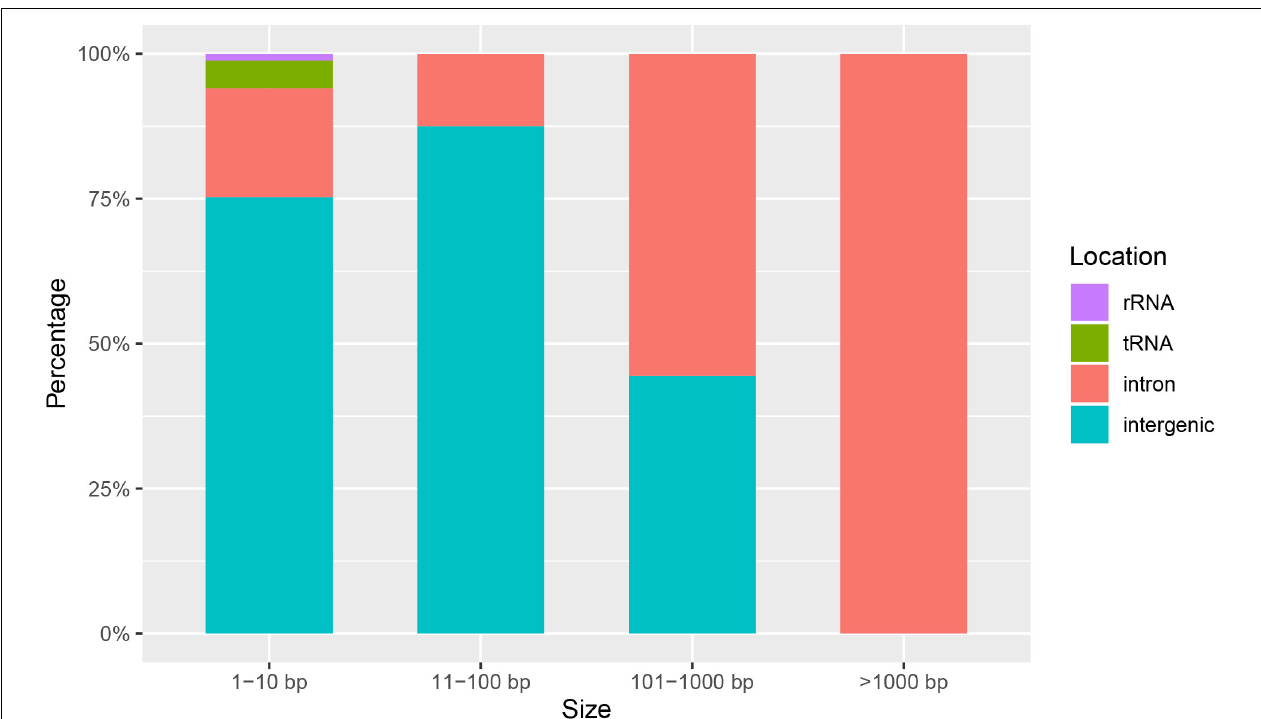
FIGURE 6 | Length distribution of indels in intergenetic, intron, rRNA, and tRNA between different length of intervals in the mitogenome of F. asiaticum and F.